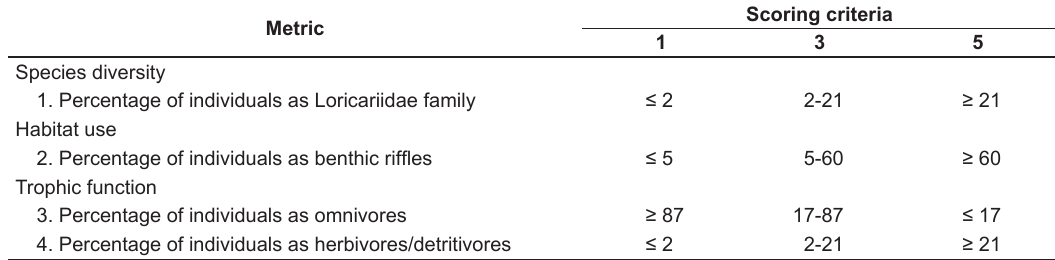
Table 6. IBI metrics and scoring criteria for Atlantic Forest of south São Paulo State streams.